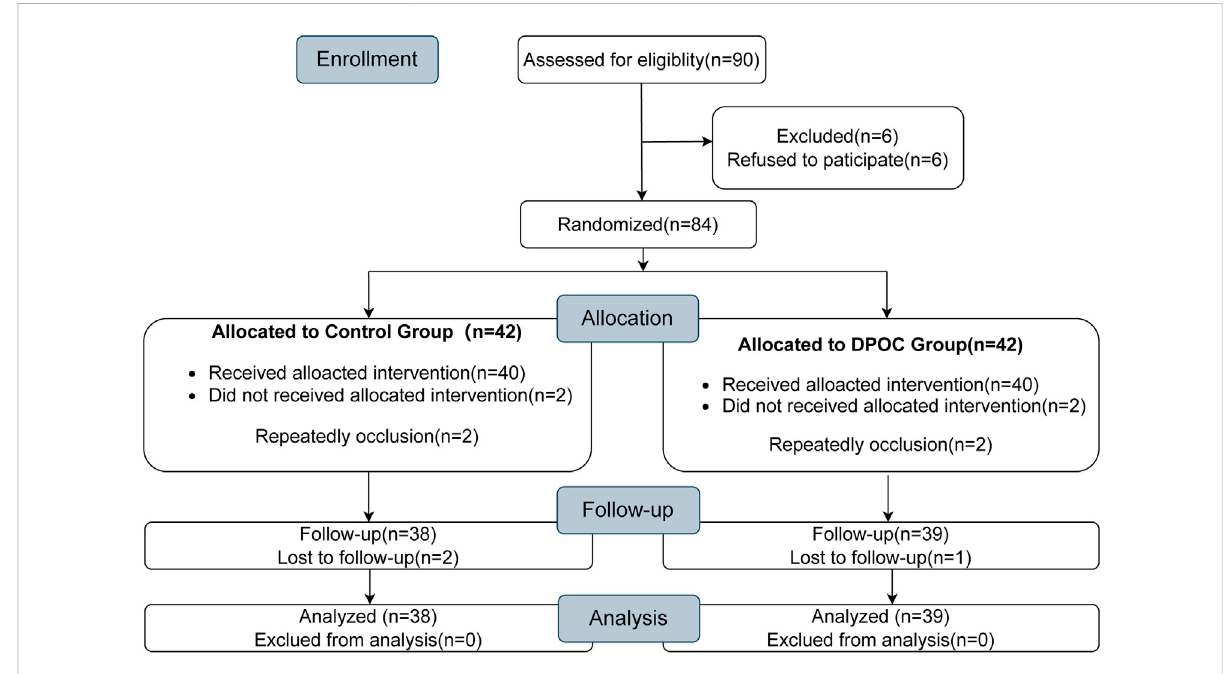
FIGURE 1 CONSORT diagram showing the fl ow of participants throughout each stage of the randomized